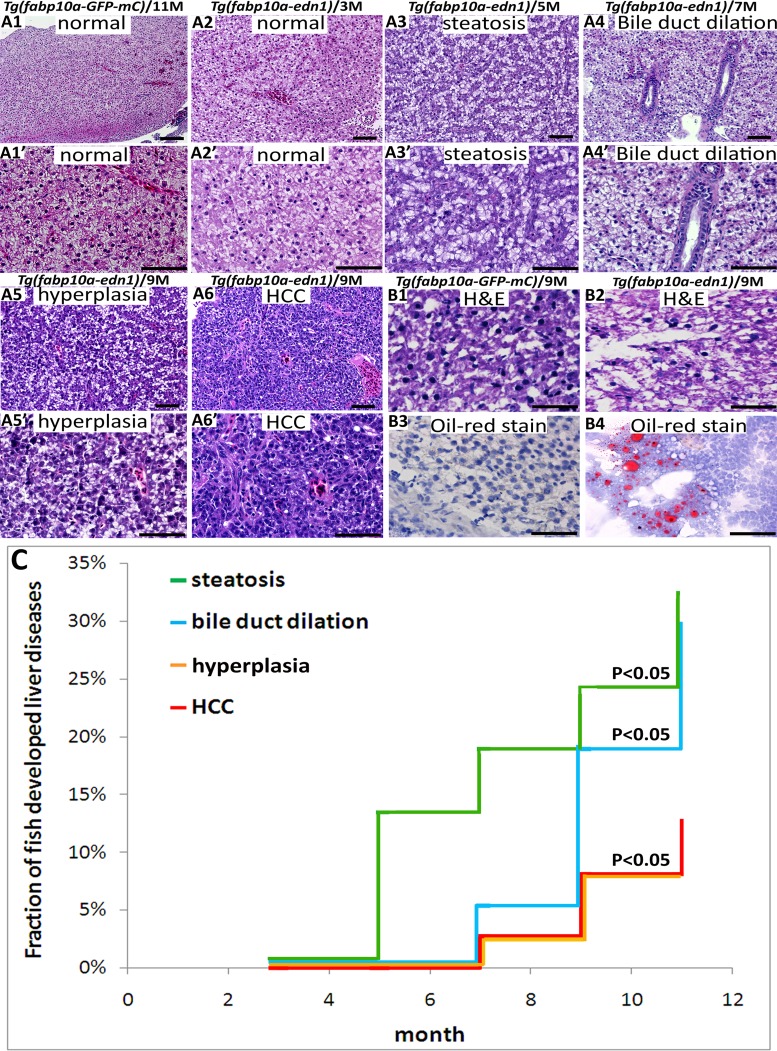
Histopathology of edn1 transgenic hepatocytes.(A1–A6) H&E staining of the liver sections from the GFP-mCherry control fish at 11 months (A1), and from the edn1 transgenic fish at 3, 5, 7, 9 months (A2–A6). The images were captured at 200X magnification. The A1′–A6′ images resemble the A1–A6 images, though they were captured at 400X magnification. H&E staining of liver sections from GFP-mCherry control fish showed normal histology, while edn1 transgenic fish showed normal, steatosis, bile duct dilation, hyperplasia, and HCC at 3, 5, 7, and 9 months. Scale bars: 50 µm. (B). The Tg(fabp10a:GFP-mCherry) and Tg(fabp10a:edn1-pA/CG2) liver sections were stained by H&E (B1 and B2). The same sections were also stained with oil red O (B3 and B4). Tissues from the Tg(fabp10a:edn1-pA/CG2) fish showed positive staining with oil red O in the hepatocytes (400X). Scale bars: 50 µm. (C) The cumulative frequency of steatosis, bile duct dilation, hyperplasia, and HCC in the edn1 transgenic fish was determined by Kaplan-Meier analysis. The different colors denote different liver diseases: steatosis (green), bile duct dilation (blue), hyperplasia (brown), and HCC (red). The differences between the edn1 transgenic fish and control fish were assessed using a two-tailed Student's t-test. The P value is less than 0.05.